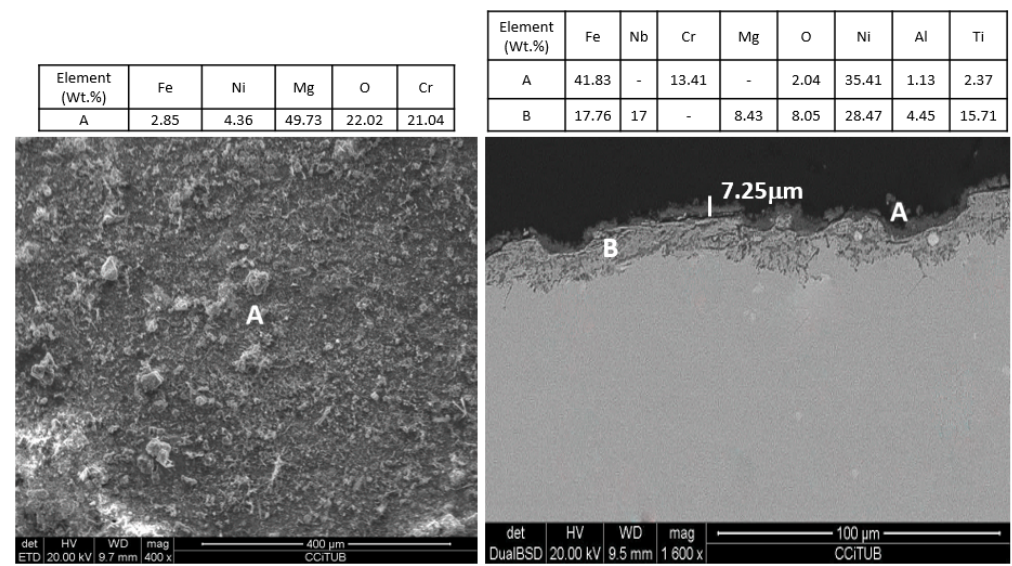
Figure 8. Micrographs showing a top view ( left ) and a cross section ( right ) of OCT immersed in ternary chloride molten salt for 8 h at 720 °C; EDX analysis is shown on top.